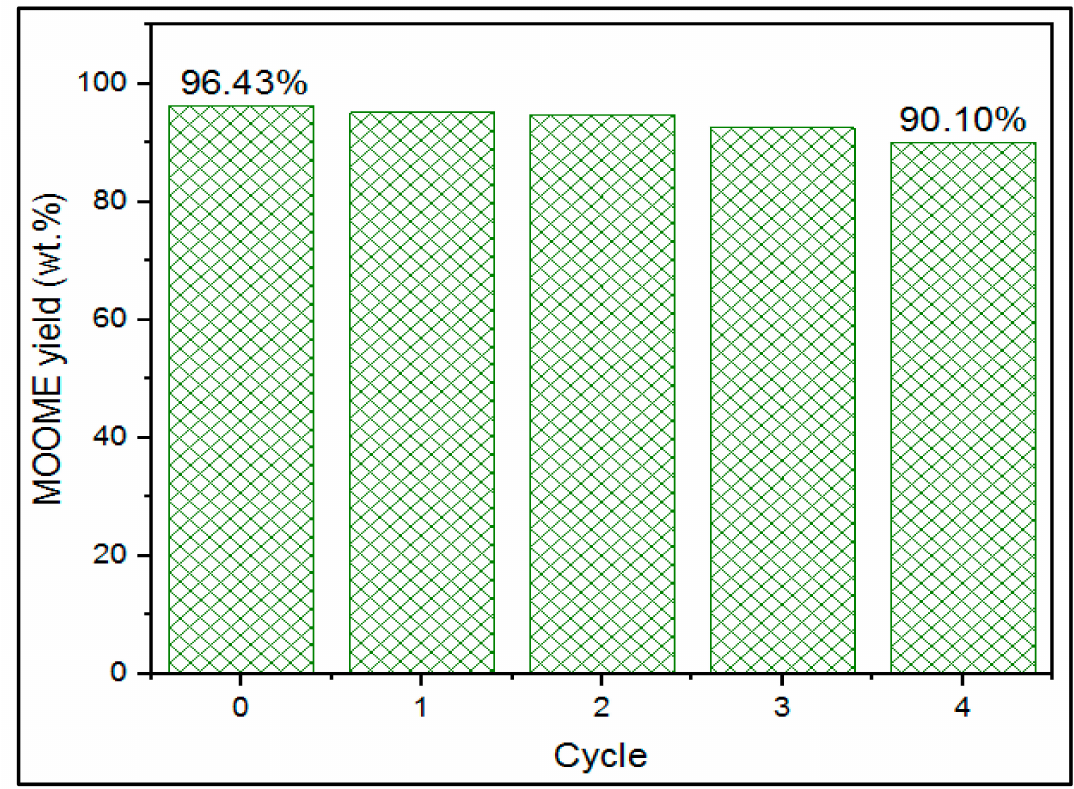
Figure 7. Reusability potential test of